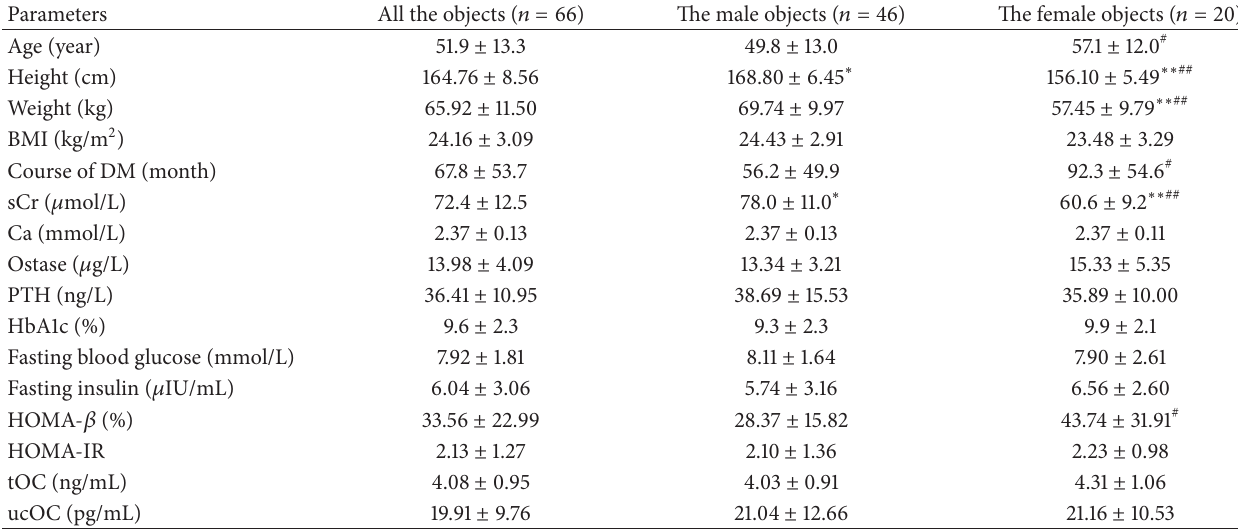
Table 1: The principal characteristics of the research objects.